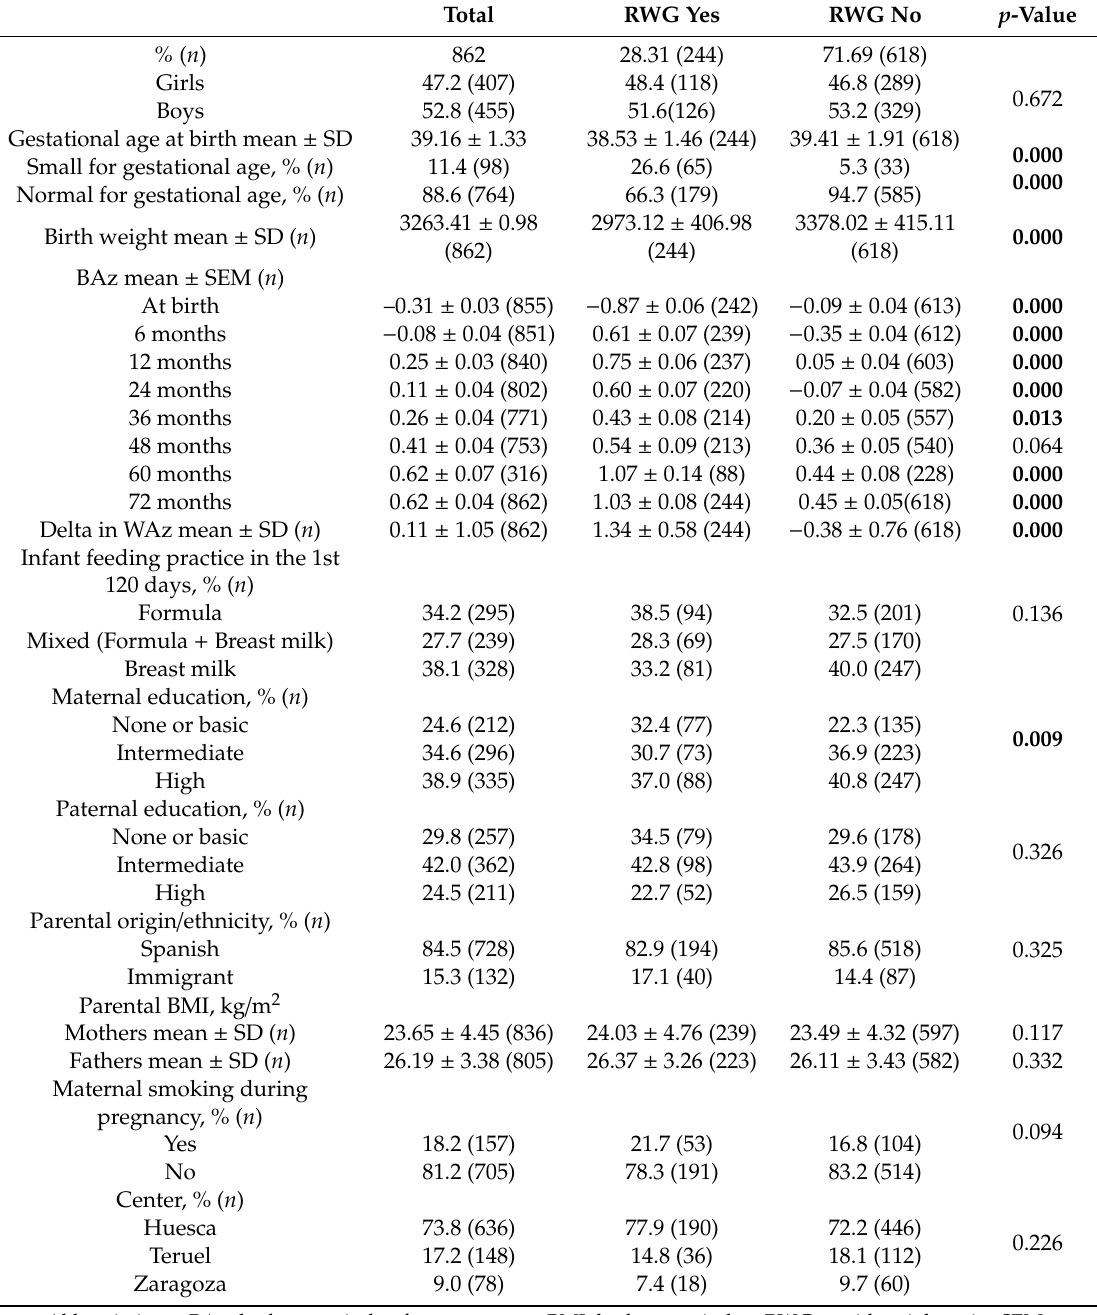
Table 1. Descriptive characteristics of participants according to rapid weight